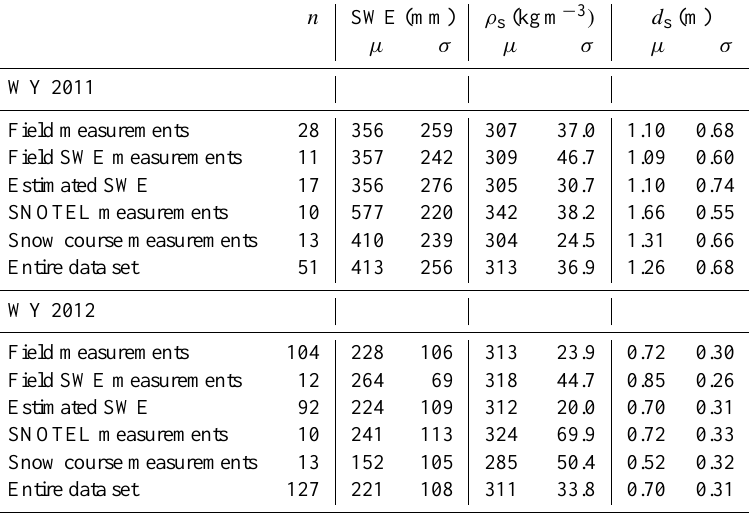
Fig. 4. Snow density model versus observed snow density and SWE calibration with historic snow course data and validation with indepen- dent field data. Modeled SWE is derived from modeled snow density and observed snow depth. Table 2. Summary statistics ( µ = mean, σ = standard deviation) for snowpack properties from WY 2011 and WY 2012 snow surveys. Statistics calculated separately for manual and operational measurements as well as manual measurements in which SWE was estimated from the snow density